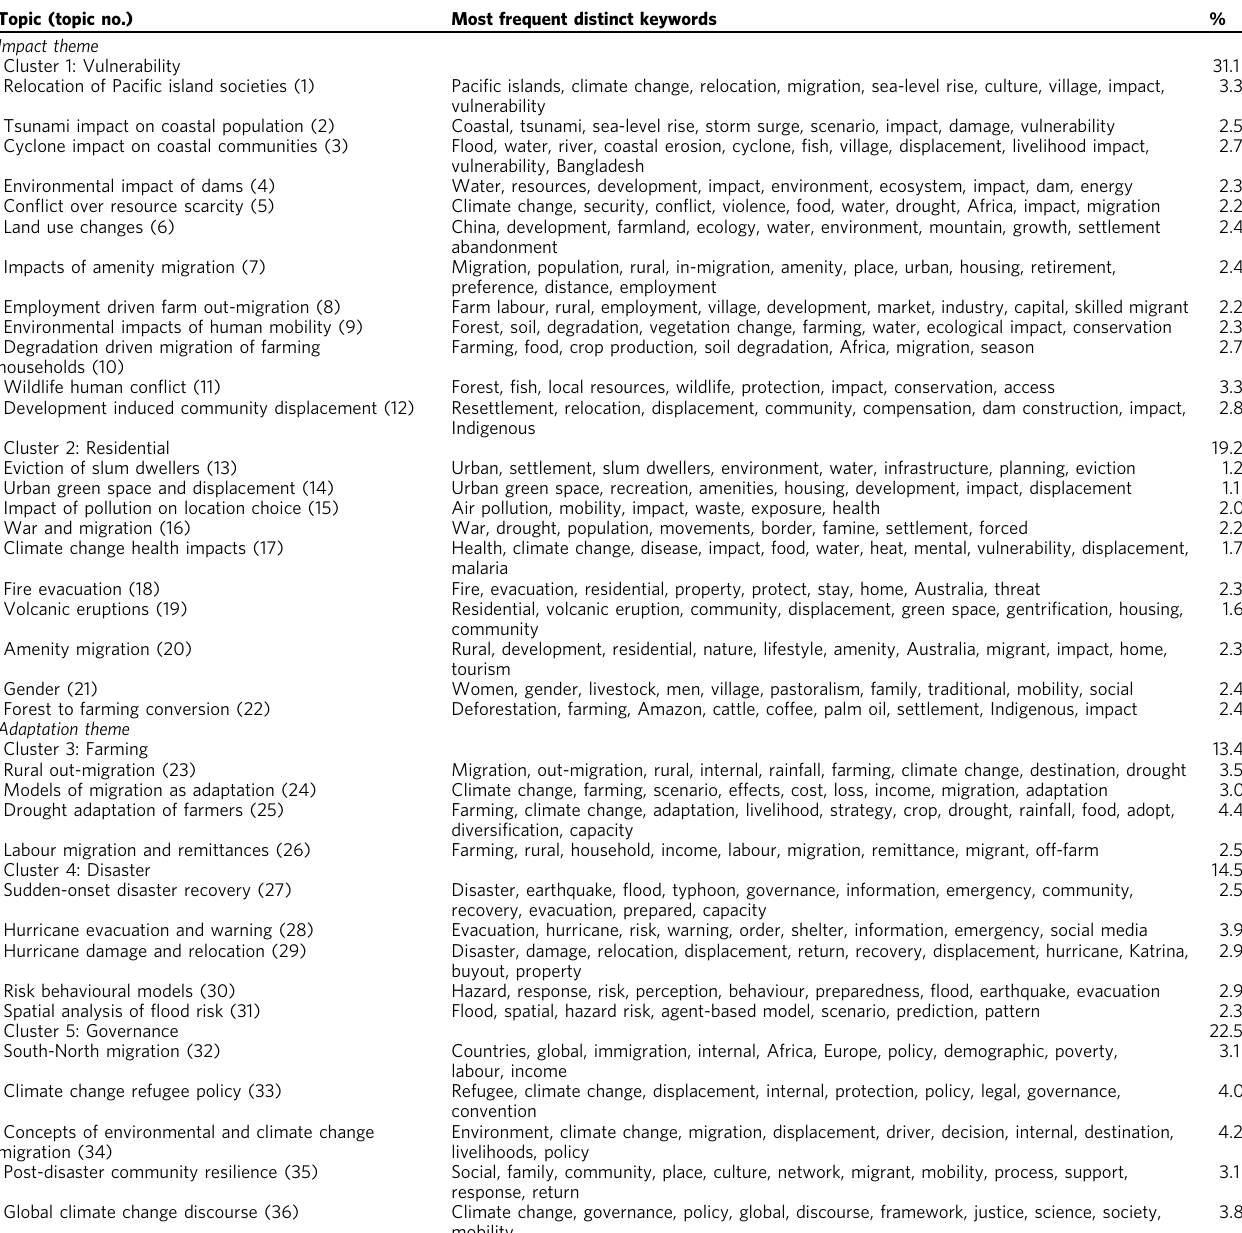
Table 2 Themes, clusters and topics emerging from textual analysis of peer-reviewed articles on environmental and climate- related migration from 1991 to 2020. Frequent terms within topics (see the full list of terms in Table S1 in SM) and the percentage of articles belonging to each topic are shown. Each topic was classi fi ed as being closest linguistically to those to which it is